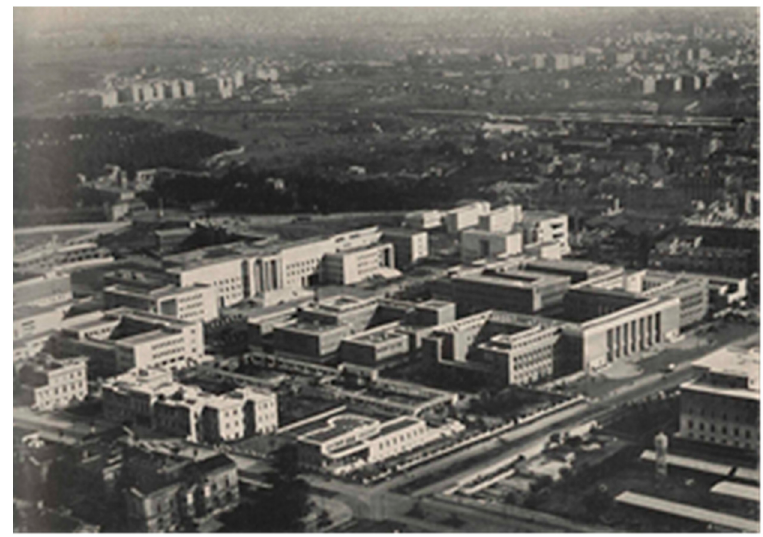
Figure 27. The campus of Sapienza University of Rome (1993–1935). Photo from (Baliviera et al. 1935, p. 5).